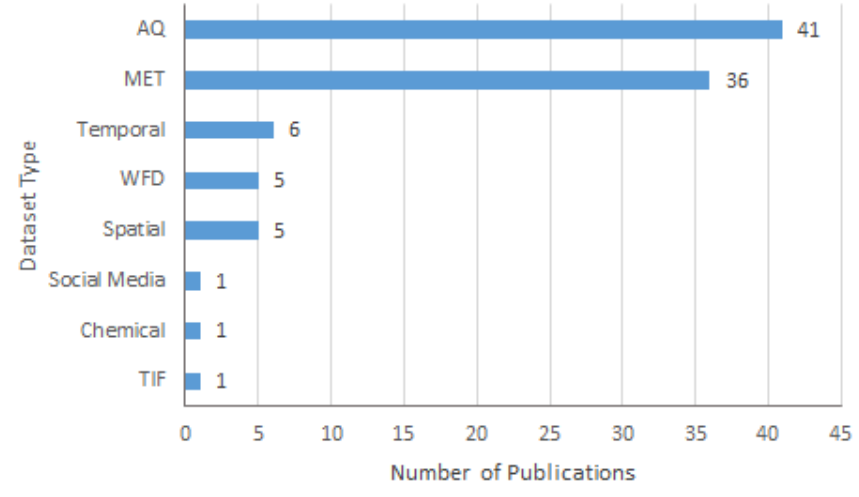
Figure 12. Dataset types used in the selected publications.